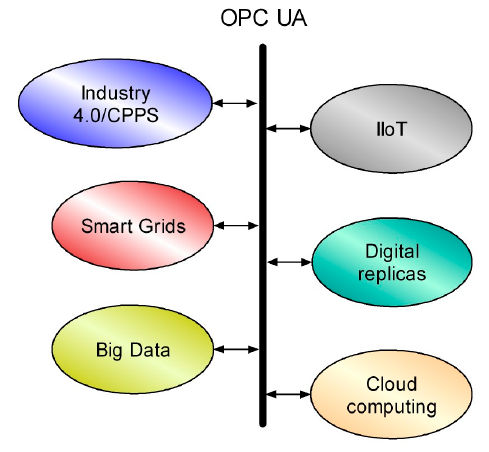
Figure 14. Interplay of OPC unified architecture (UA) in the challenges.